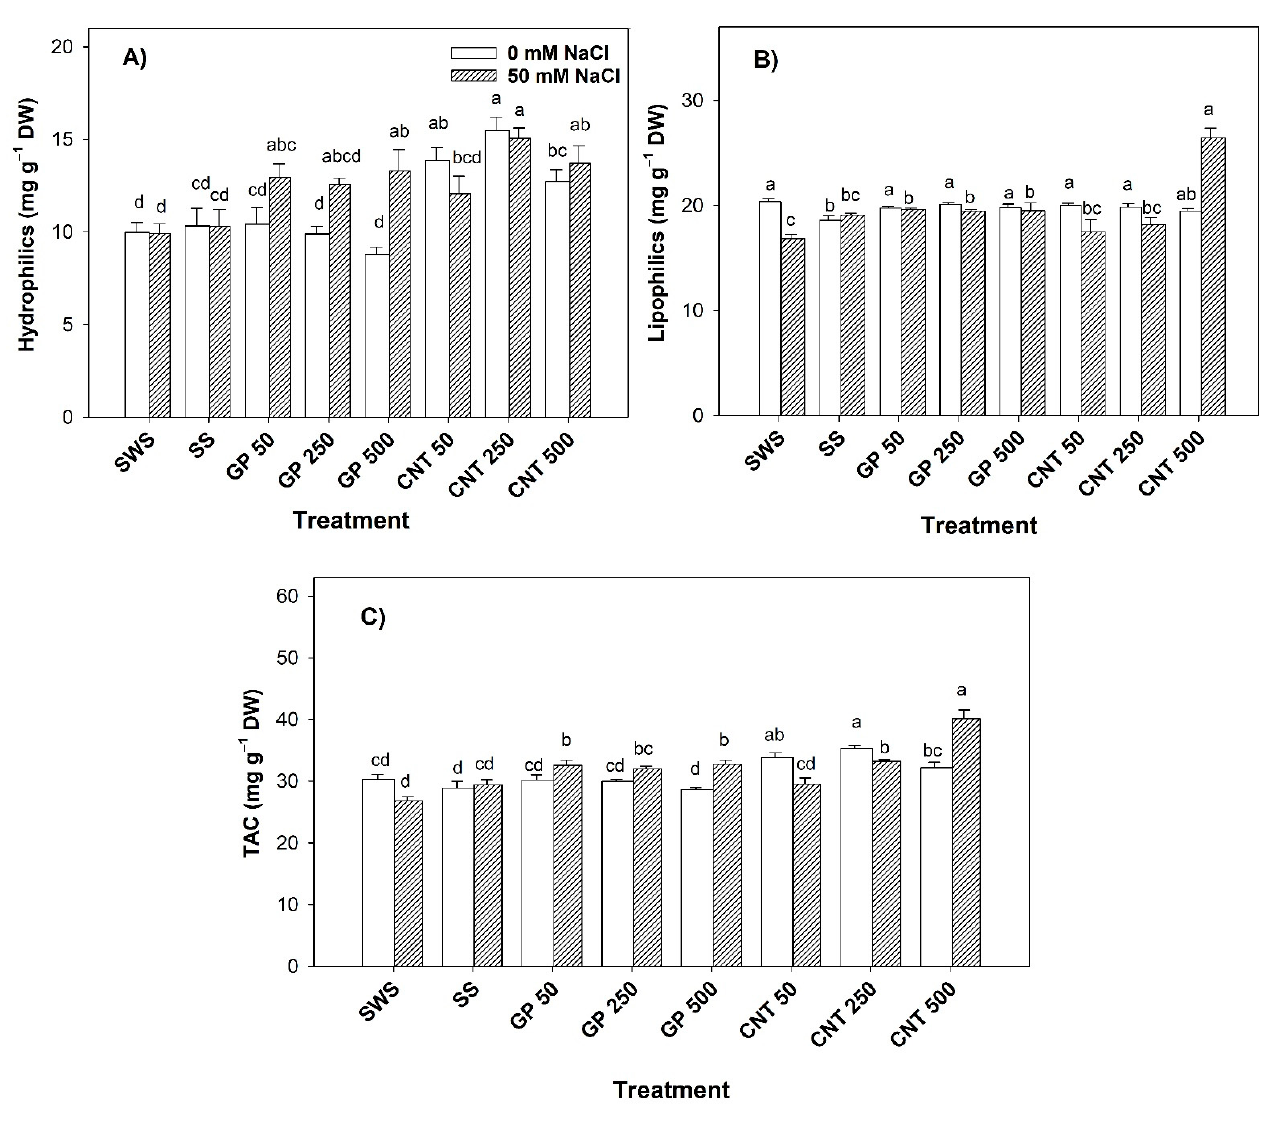
Figure 7. Antioxidant capacity in fruits of tomato plants treated with carbon nanomaterials and salinity: ( A ) hydrophilics antioxidant capacity, ( B ) lipophilics antioxidant capacity, and ( C ) total antioxidant capacity (TAC). DW: dry weight; SWS: non-sonicated seeds; SS: sonicated seeds; GP: graphene; CNT: carbon nanotubes; 50, 250, and 500 represent the mg L − 1 applied of carbon nano- material. Different letters indicate a significant difference between treatments according to Fisher ( α = 0.05). n = 6 ± standard error.